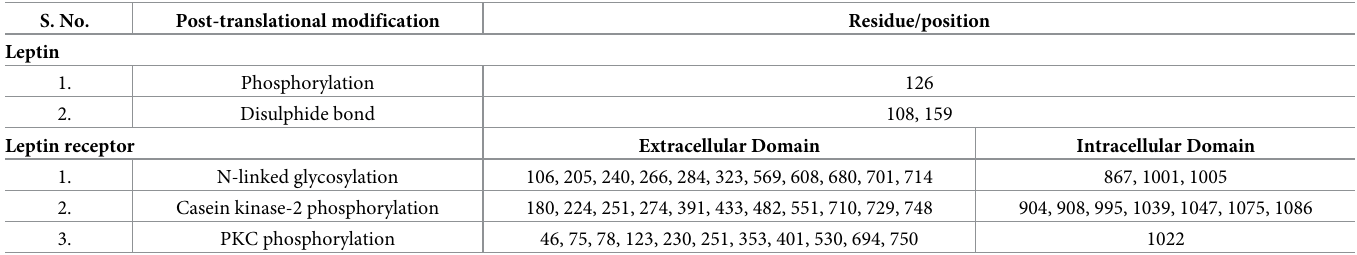
Table 4. Predicted post-translational modifications in leptin and leptin receptor of Channa punctata . S.